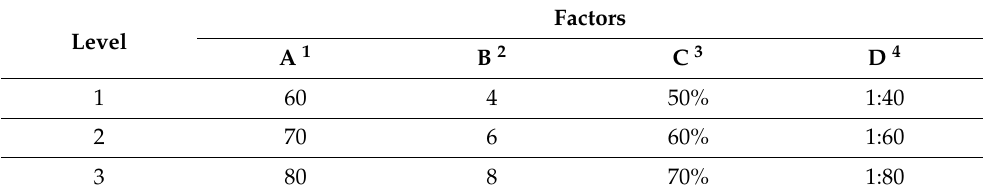
Table 1. Orthogonal test